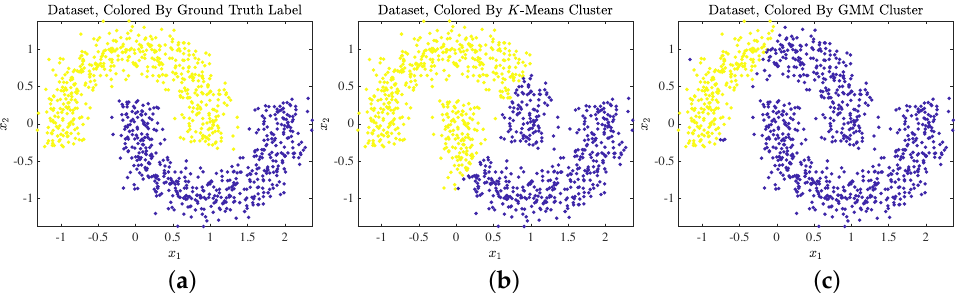
Figure 1. Example of a toy dataset ( n = 1000 ) with nonlinear cluster structure: two interleaving half-circles. The idealized clustering, visualized in ( a ), separates each half-circle. Due to the lack of a linear decision boundary, however, both K -Means ( b ) and GMM ( c ) were unable to extract latent cluster structure from this simple nonlinear dataset. Both algorithms were run with 100